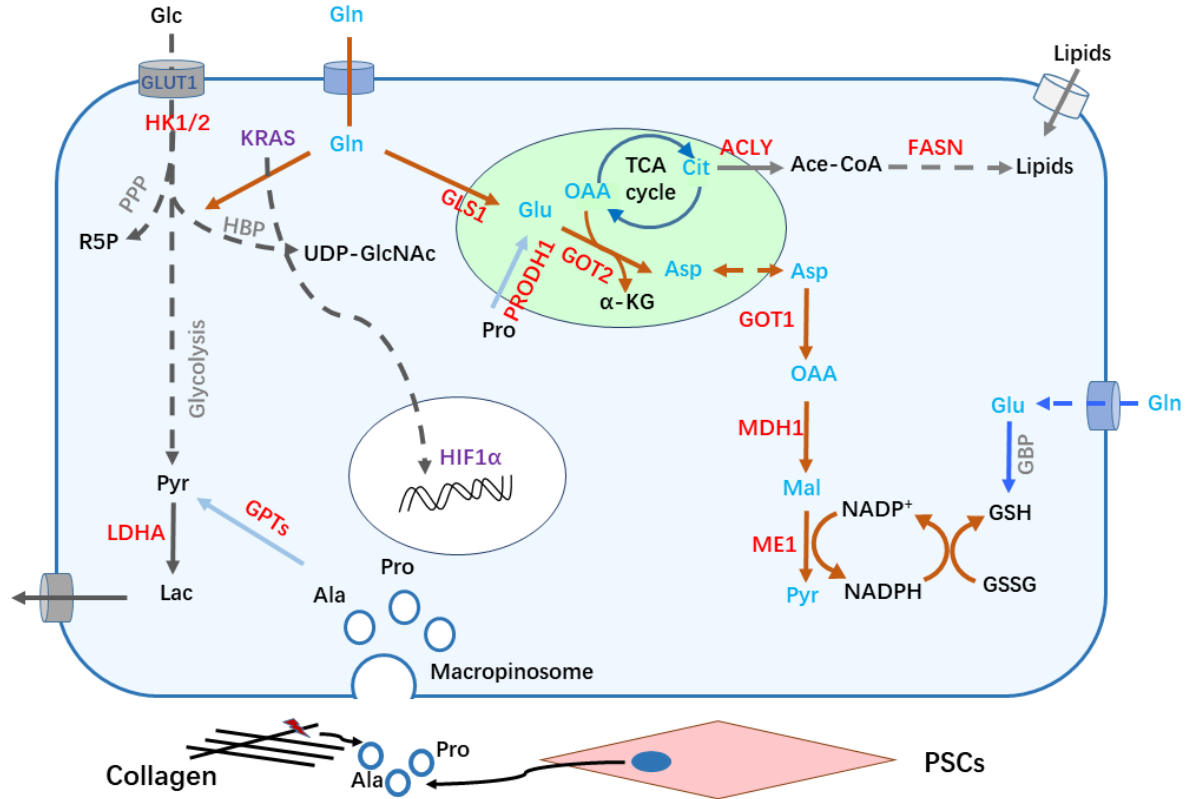
FIGURE 2: Metabolic remolding in PDAC cells. ( 1 ) KRAS (in cytoplasm) and HIF1 α activation in PDAC cells upregulates glucose transporter (GLUT1) and other glycolytic related genes to promote glucose (Glc) uptake and enhance glycolysis flux, including the production of lactate (Lac) and carbon donation into the hexosamine biosynthetic pathway (HBP) and pentose phosphate pathway (PPP). ( 2 ) KRAS activation re- programs Gln metabolism to balance cellular redox homeostasis. Gln is sequentially converted to Glu and Asp catalyzed by GLS1 and GOT2 in the mitochondria, Asp is shuttled to the cytoplasm and generates NADPH after a series of reactions to maintain redox homeostasis. ( 3 ) The lipid synthesis pathway is activated, citrate is shuttled from the mitochondria into the cytoplasm to produce acetyl CoA (Ace-CoA), thereby enhancing de novo lipid synthesis pathway. Concomitantly, uptake of exogenous lipids is increased to meet the demand of nutrients for rapid proliferation. ( 4 ) The tumor microenvironment, including ECM components and stromal cells, also provide various metabolites/nutrients for PDAC cells, such as Ala and Pro derived from collagen degradation or pancreatic stellate cells (PSCs) secretion. The gene expression of mole- cules labeled in red color are up-regulated. α -KG: alpha ketoglutarate; Ace-CoA: acetyl-Coenzyme A; ACLY: ATP-citrate lyase; Ala: alanine; Asp: aspartate; Cit: citrate; FASN: fatty acid synthase; Glc: glucose; Gln: glutamine; GLS1: glutaminase; Glu: glutamate; GOT: g